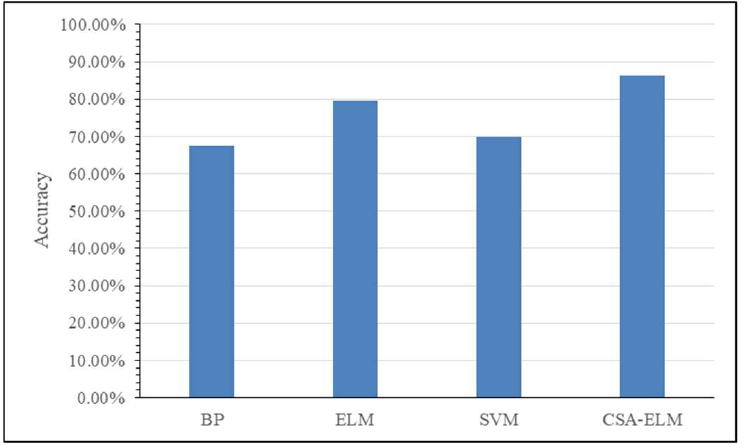
Figure 10. Intention identification accuracy of BP, ELM, SVM, and CSA-ELM methods.